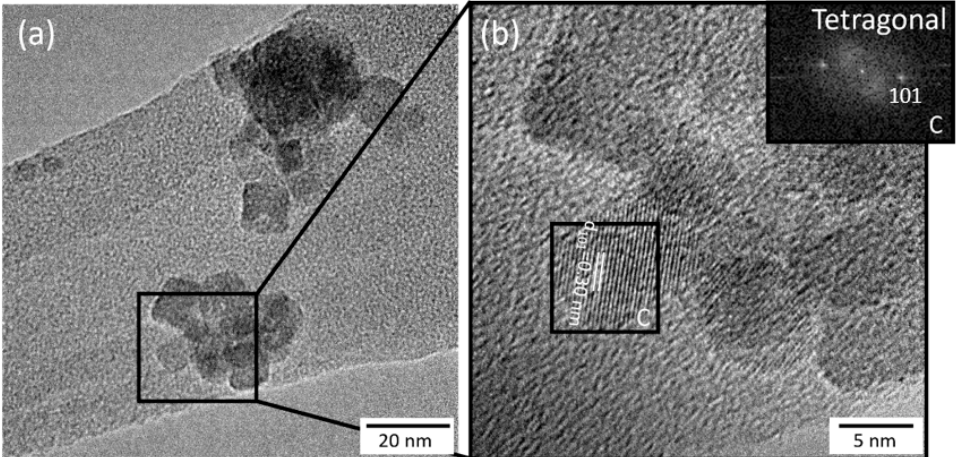
Figure 9. TEM images of the ZrO 2 powder produced with solution combustion synthesis and annealed in air at 350 ◦ C for 1 h. ( a ) Bright-field TEM image of the ZrO 2 nanoparticles and ( b ) high- resolution TEM images of the ZrO 2 nanocrystals. The inset in ( b ) shows the FFT images of the area (black square) indicated as C.